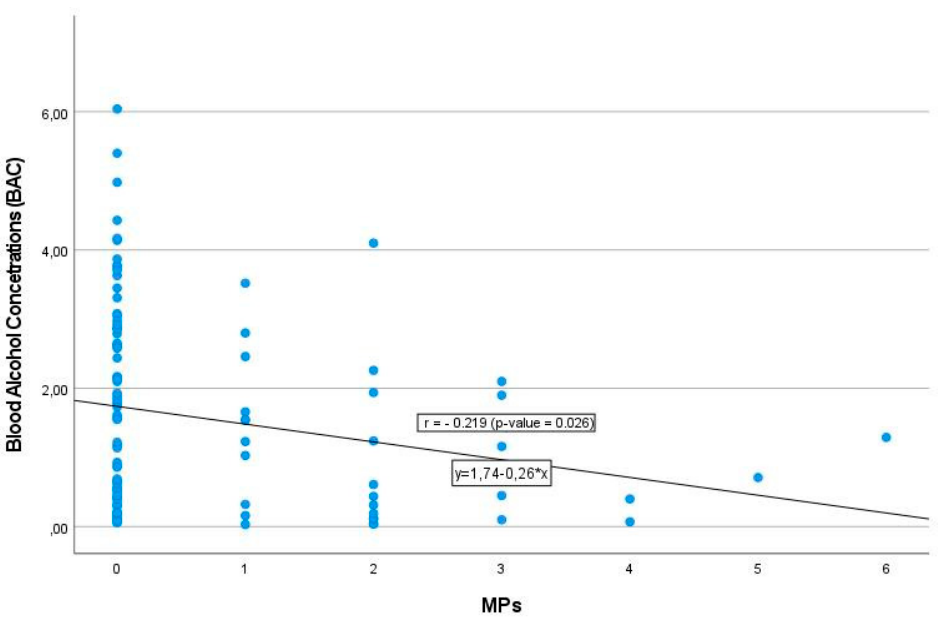
Figure 3. Inverse relationship in men among number of MPs detected and blood alcohol concentra- tions (BAC; g/L). r = 0.219; p = 0.026, Pearson’s linear correlation coefficient.